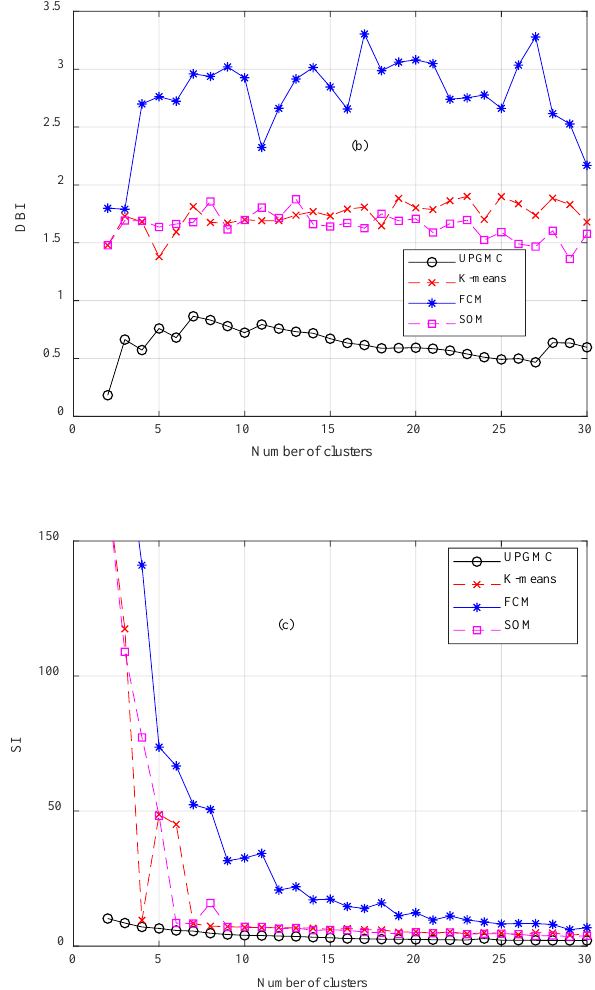
Figure 7. Algorithms comparison using: ( a ) J; ( b ) DBI; ( c ) SI indicators. The patterns dimension is D = 1440.